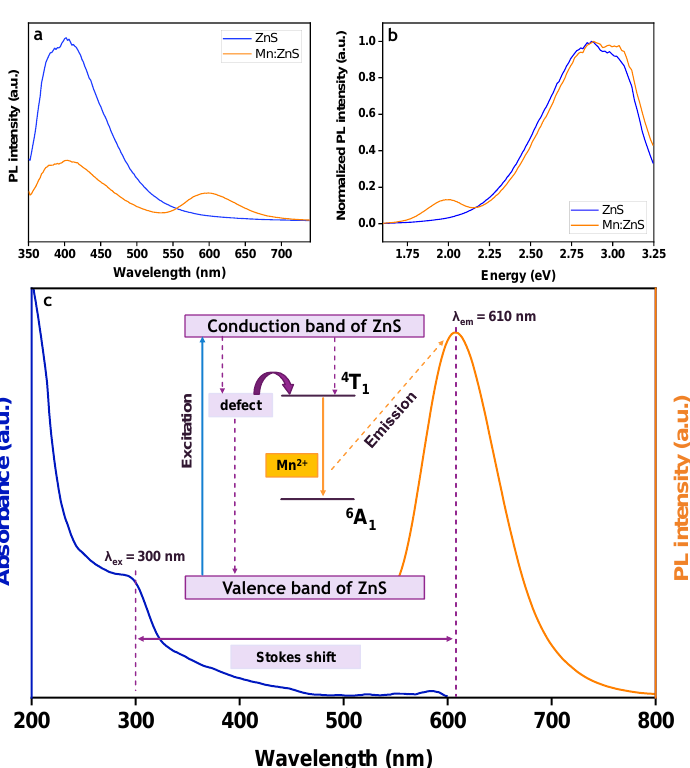
Figure 2. Comparison of ( a ) PL spectra, ( b ) normalized PL spectra, and ( c ) schematic representation for electron transition among ZnS and Mn:ZnS nanostructures.